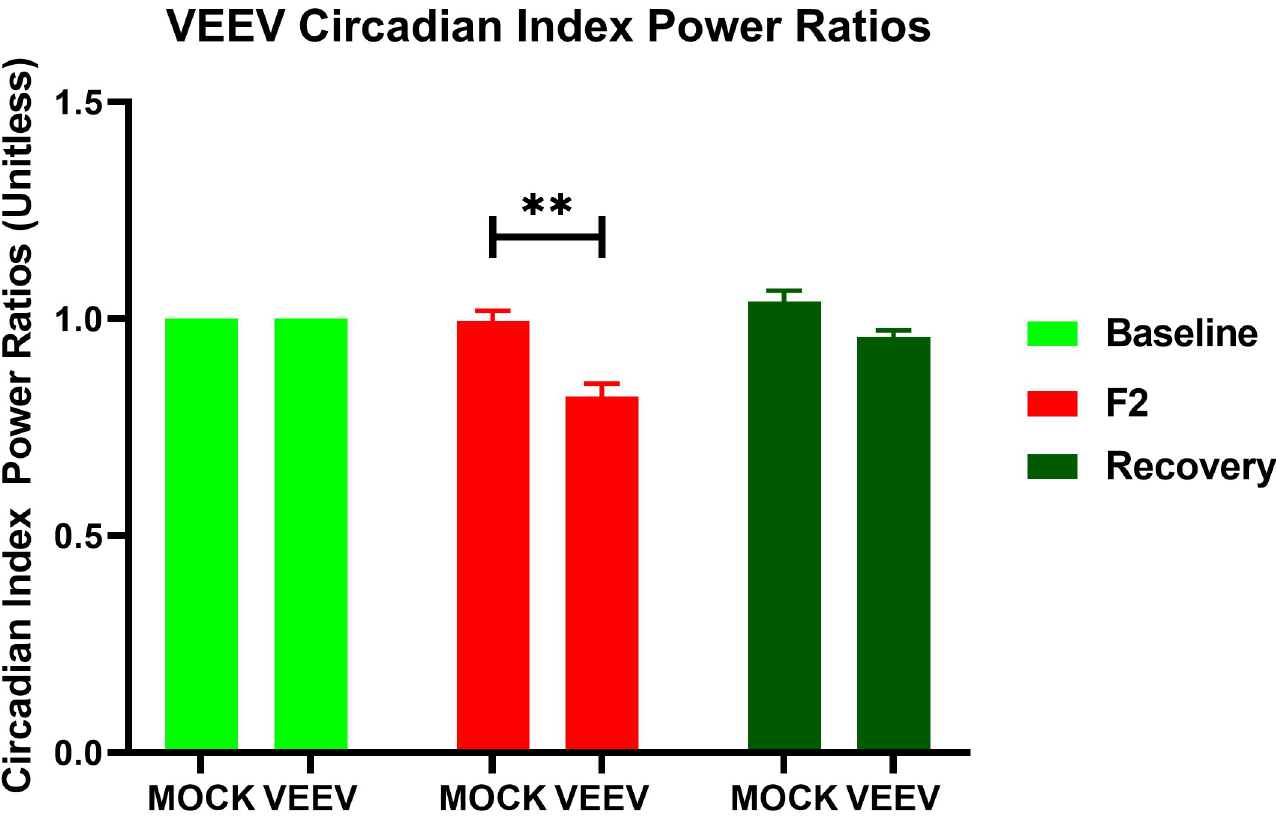
Fig 5. Circadian index power ratios suggest circadian disruption during second febrile phase of VEE. Repeated measures ANOVA of circadian index power ratios of mock-infected macaques and macaques infected with VEEV show the suppression of circadian variation during the second febrile peak compared to baseline between VEEV-infected and mock-infected macaques ( p =